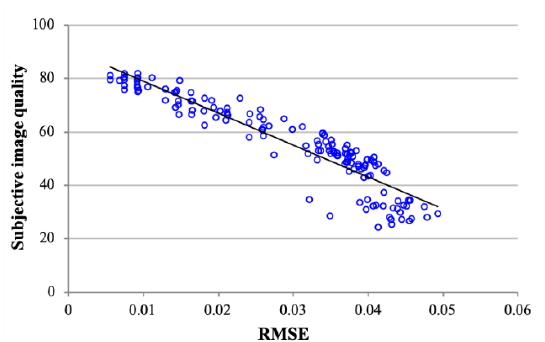
Figure 6. Relationship between the perceived image quality and root-mean-squared error (RMSE) values.